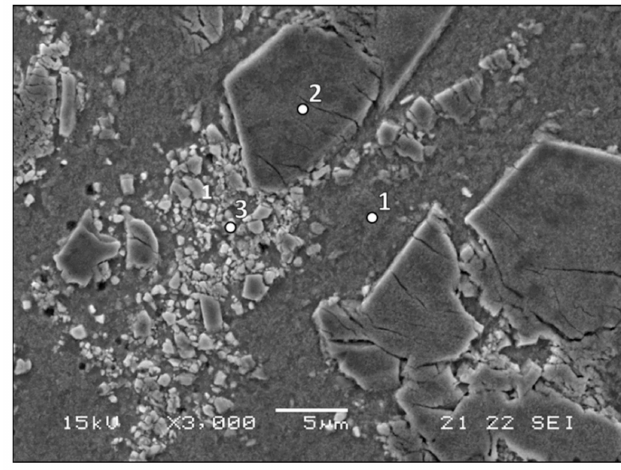
Figure 4. Close-up view by SEM of Zn-2%Fe-0.8%Mn alloy.